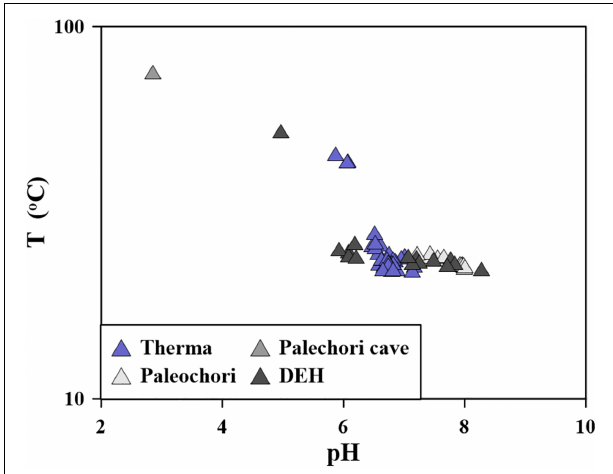
FIGURE 12 | Binary plot of pH-T for the areas where the transects took